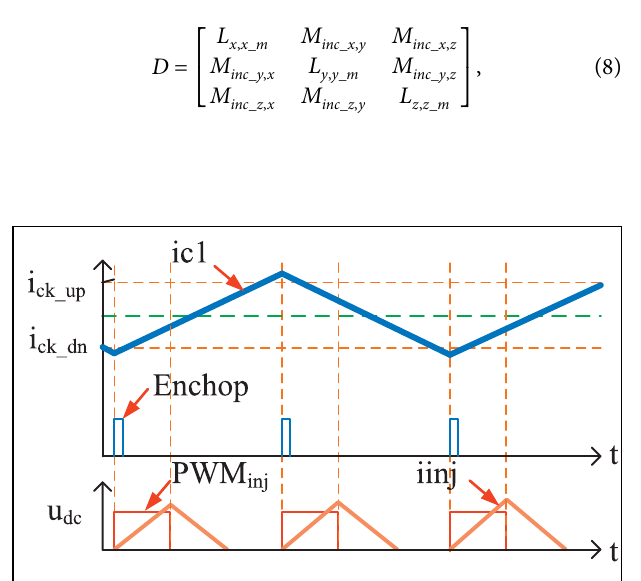
FIGURE 4 | Schematic diagram of the synchronous current chopping